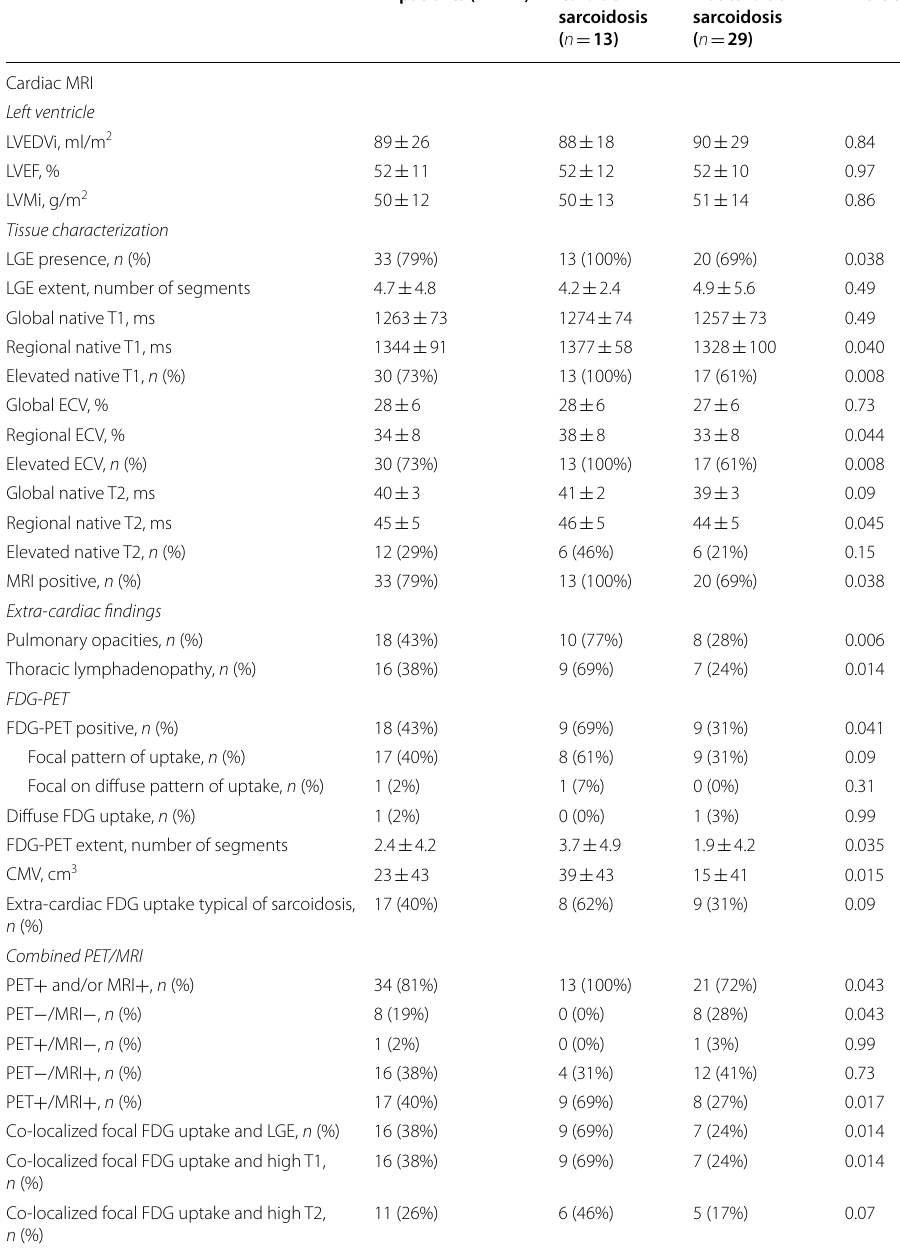
Table 2 Combined PET/MRI